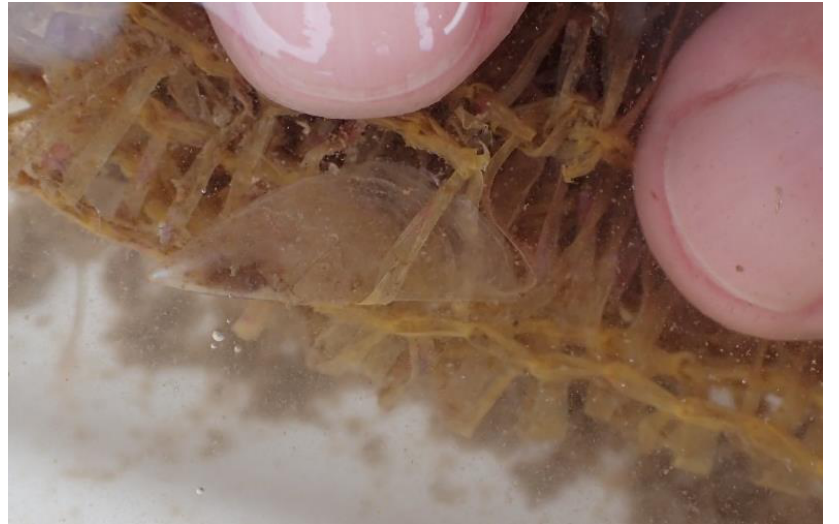
Figure 3. Juvenile Pinna nobilis on the mesh of a collector bag. It was cut out with the piece of mesh it was attached to in order not to damage its byssus gland.